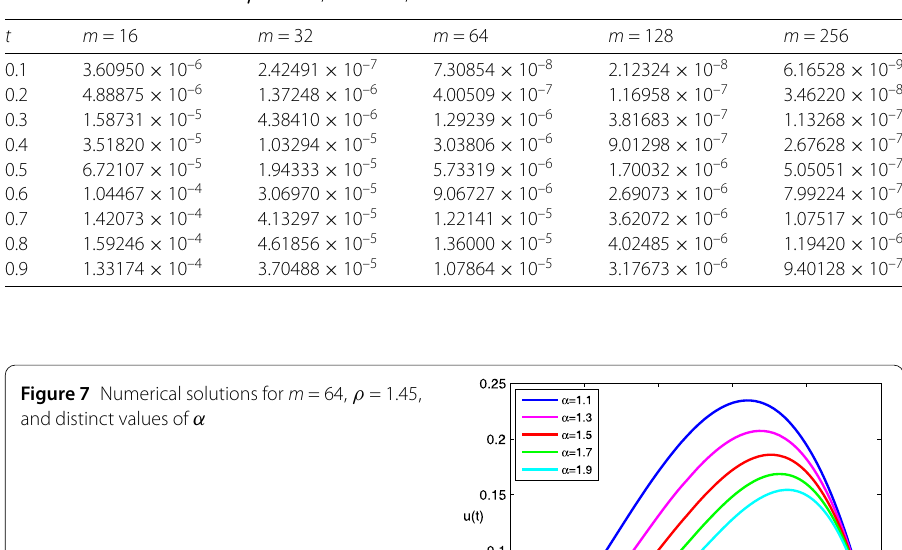
Table 7 Absolute error for ρ = 1.55, α = 1.75, and for different values of m